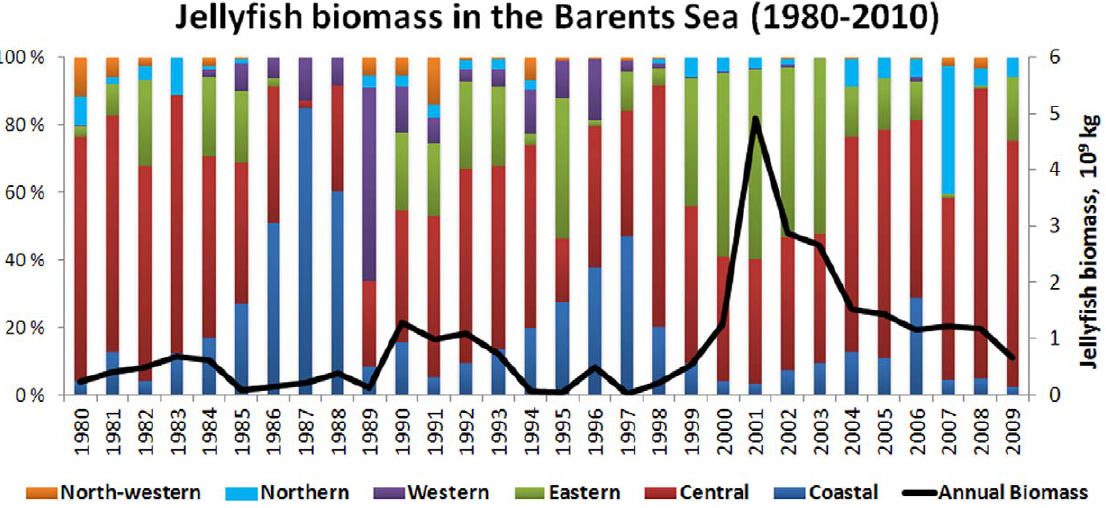
Figure 5. Variation of jellyfish biomass indices in the Barents Sea (10 9 kg, black line) and the spatial distribution of jellyfish biomass (colored bars).